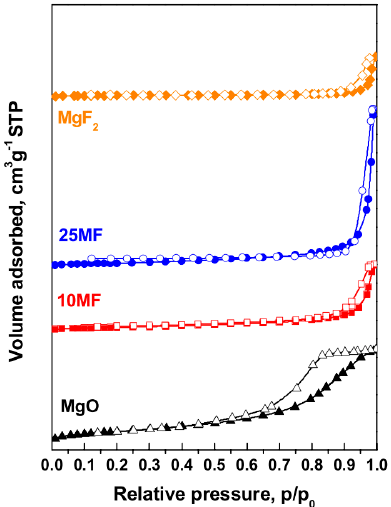
Figure 1. Nitrogen adsorption–desorption isotherms for MgF 2 , 10 MF, 25 MF, and MgO calcined at 500 °C.